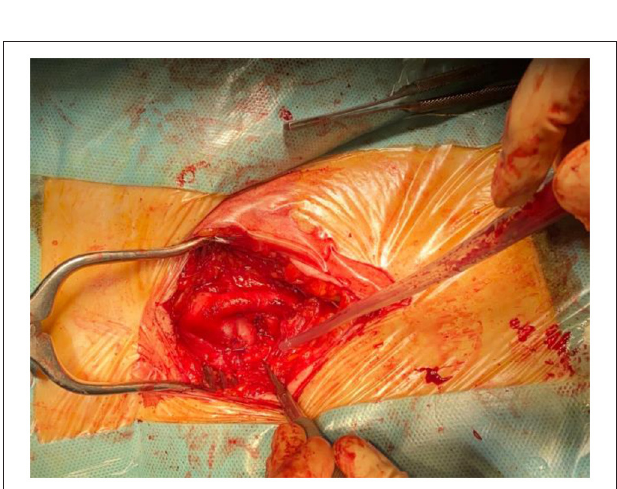
FIGURE 2 | Intraoperative photograph final aspect after the ligation the